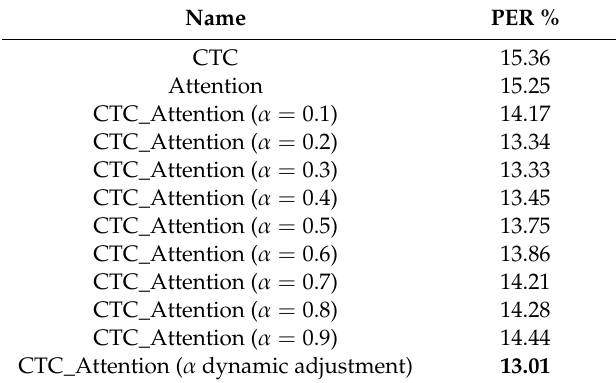
Table 6. Performance of ASR systems with di ff erent end-to-end models.